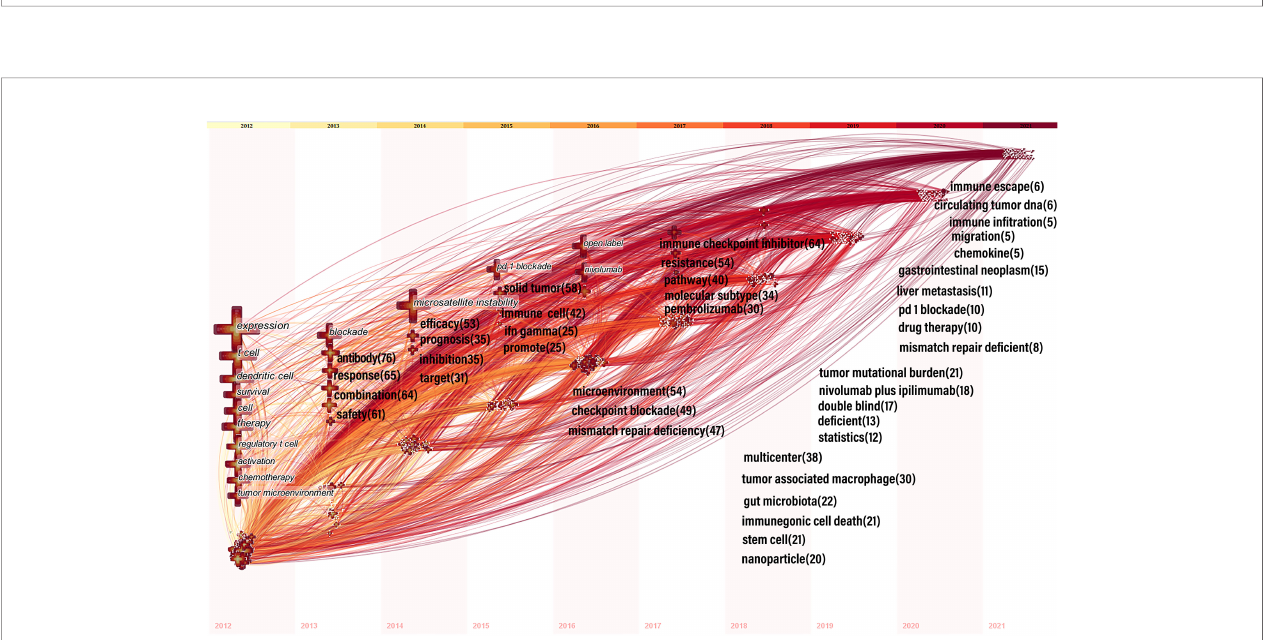
FIGURE 8 | Time zone view of keywords for colorectal cancer immunotherapy. In 2012-2016, keywords with co-occurrence rate ≥ 80 were shown; from 2013- 2021, we manually added annual top5 keywords and their co-occurrence frequency. The position of the cross on the horizontal axis represents the year in which the keyword fi rst appeared. The size of the cross re fl ects the frequency of co-occurrence, and the larger the cross represents the higher frequency of co-occurrence. The lines between the crosses represent the co-occurrence of two keywords. The lines are colored to indicate the different years. From 2012 to 2021, the color changes from yellow to